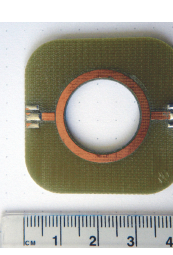
Figure 2. Microstrip ring resonator geometry and a prototype photo (line width W L = 2.2 mm, ring width W R = 2.2 mm, ring diameter D i = 2.2 mm, gap g = 0.15 mm).